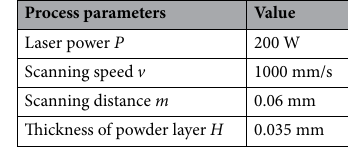
Table 2. Experimental process